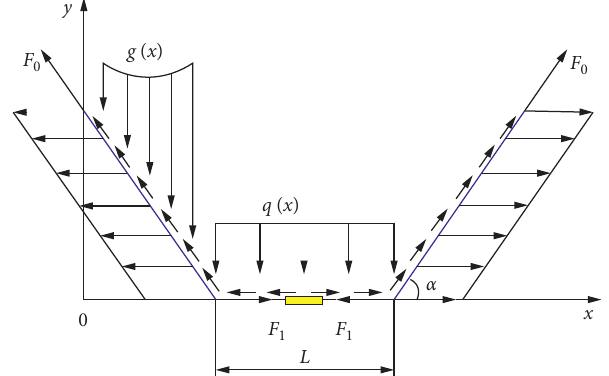
Figure 6: Stress model of the truss anchor